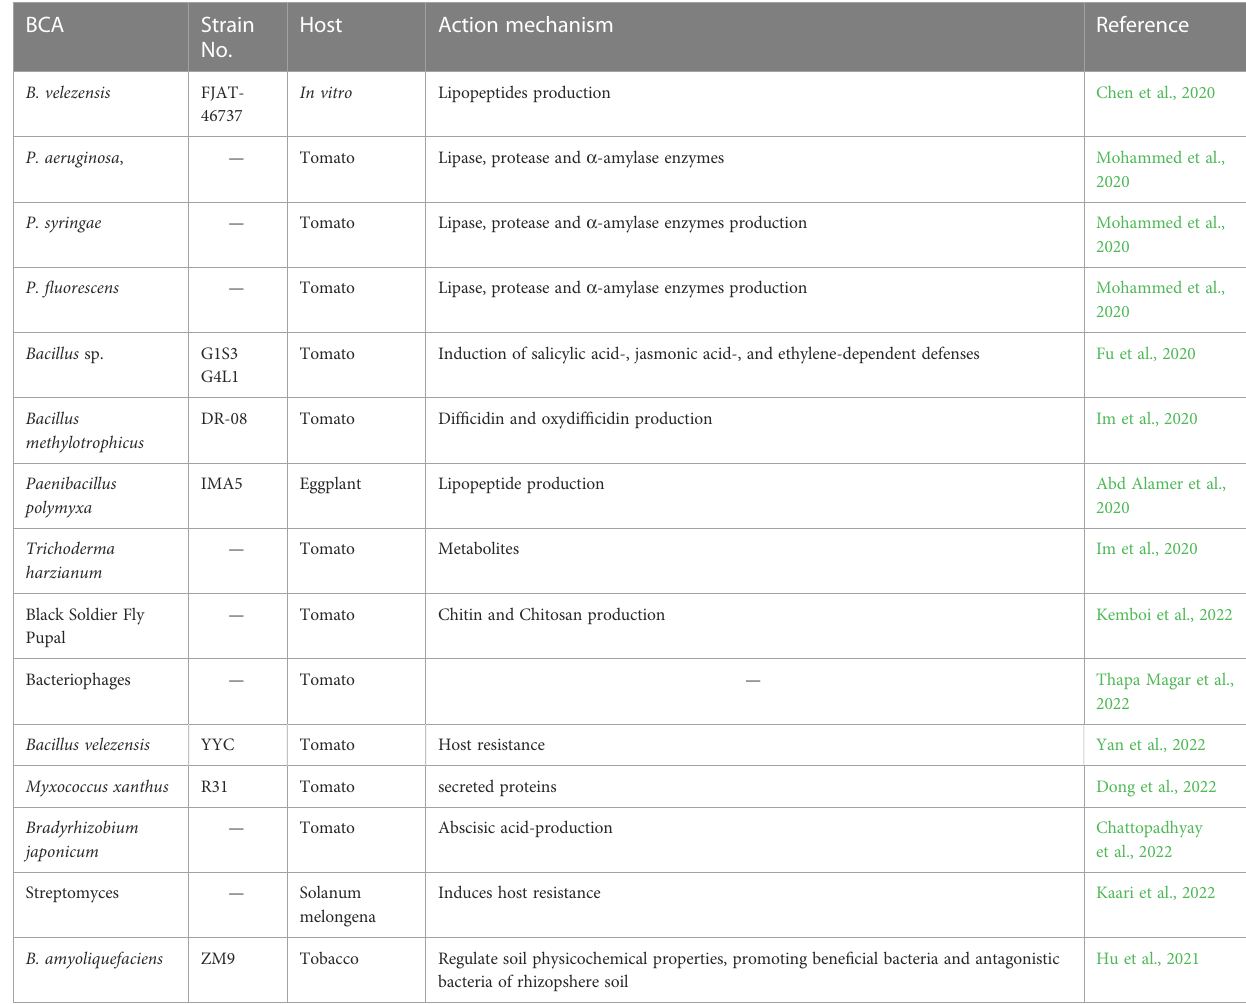
TABLE 1 Recently reported biocontrol agents and their action mechanisms against R. solanacearum and suppression of bacterial wilt disease in various